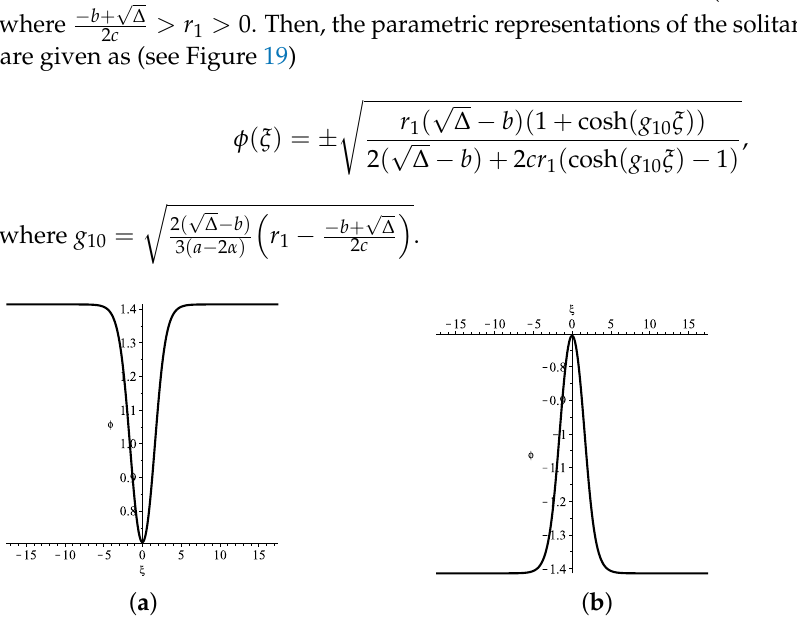
Figure 19. Solitary waves forms of system (5). ( a ) Bright solitary wave derived by (51) + . ( b ) Dark solitary wave derived by (51) −